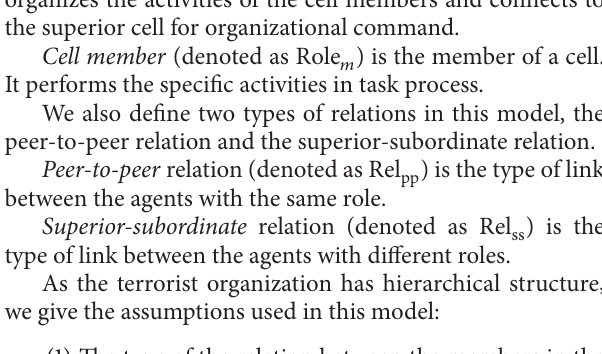
activities in specific situations. As the simulation time goes on, the statistical results are changing, and the organizational dynamics analysis is carried out based on the results captured in the